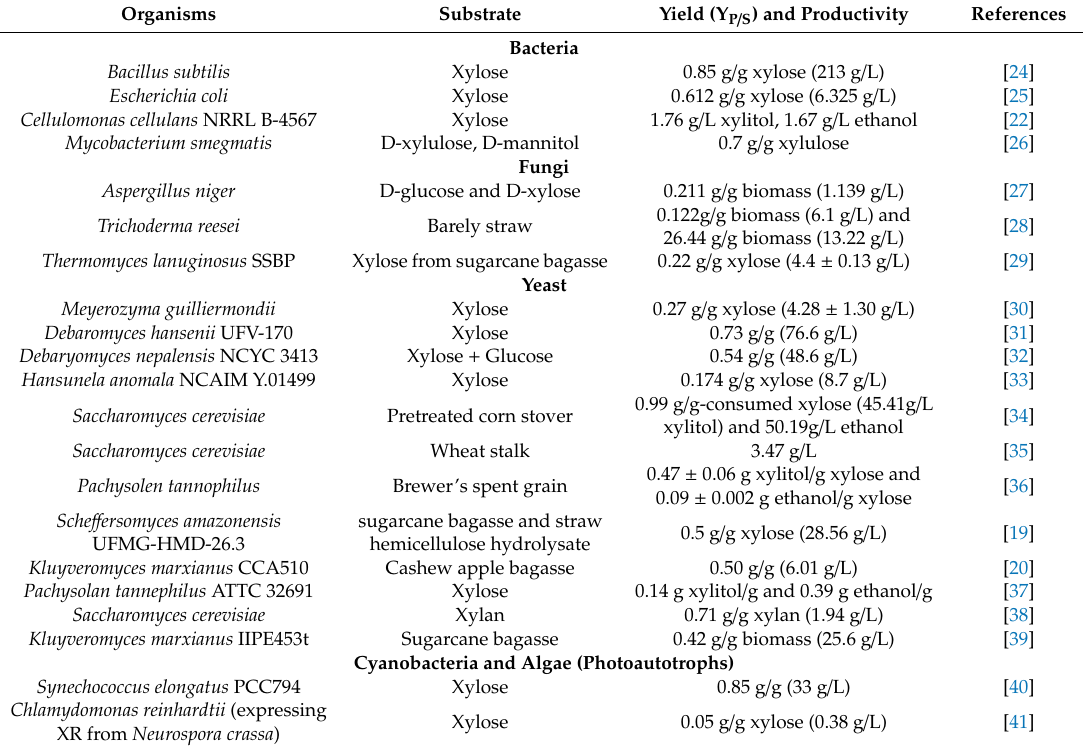
Table 3. Xylitol production by di ff erent microorganisms, and their productivity using di ff erent xylose